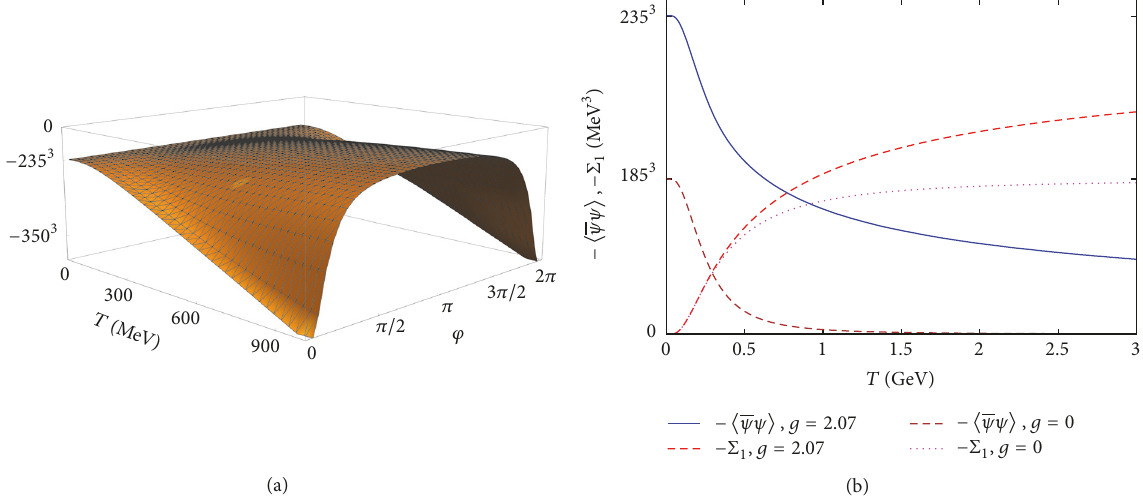
Figure 19: (a) Chiral quark condensate ⟨𝜓𝜓⟩ 휑 as function of the temperature 𝑇 and the phase 𝜑 of the boundary condition (75). (b) Chiral and dual quark condensate as function of the temperature. Results are presented for both a coupling of 𝑔 ≃ 2.1 and 𝑔 = 0 .